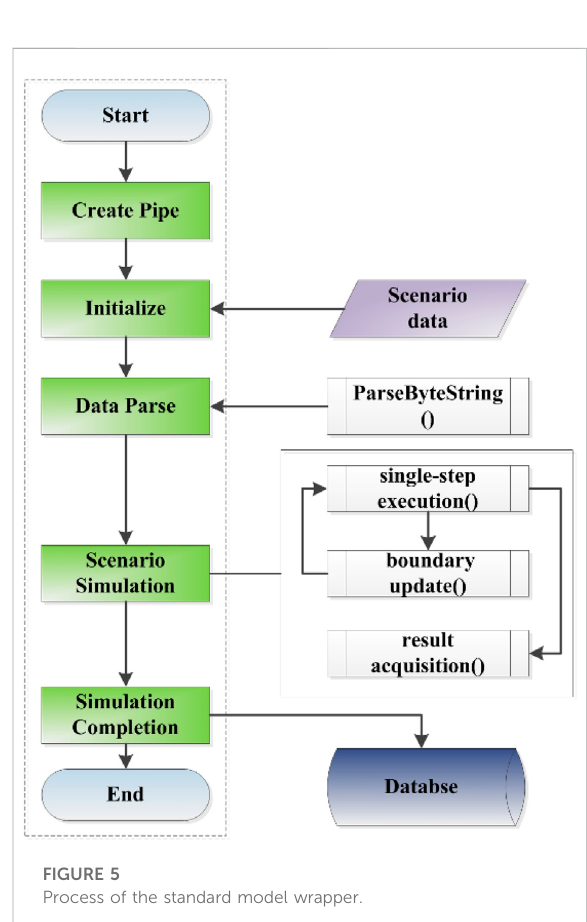
FIGURE 5 Process of the standard model